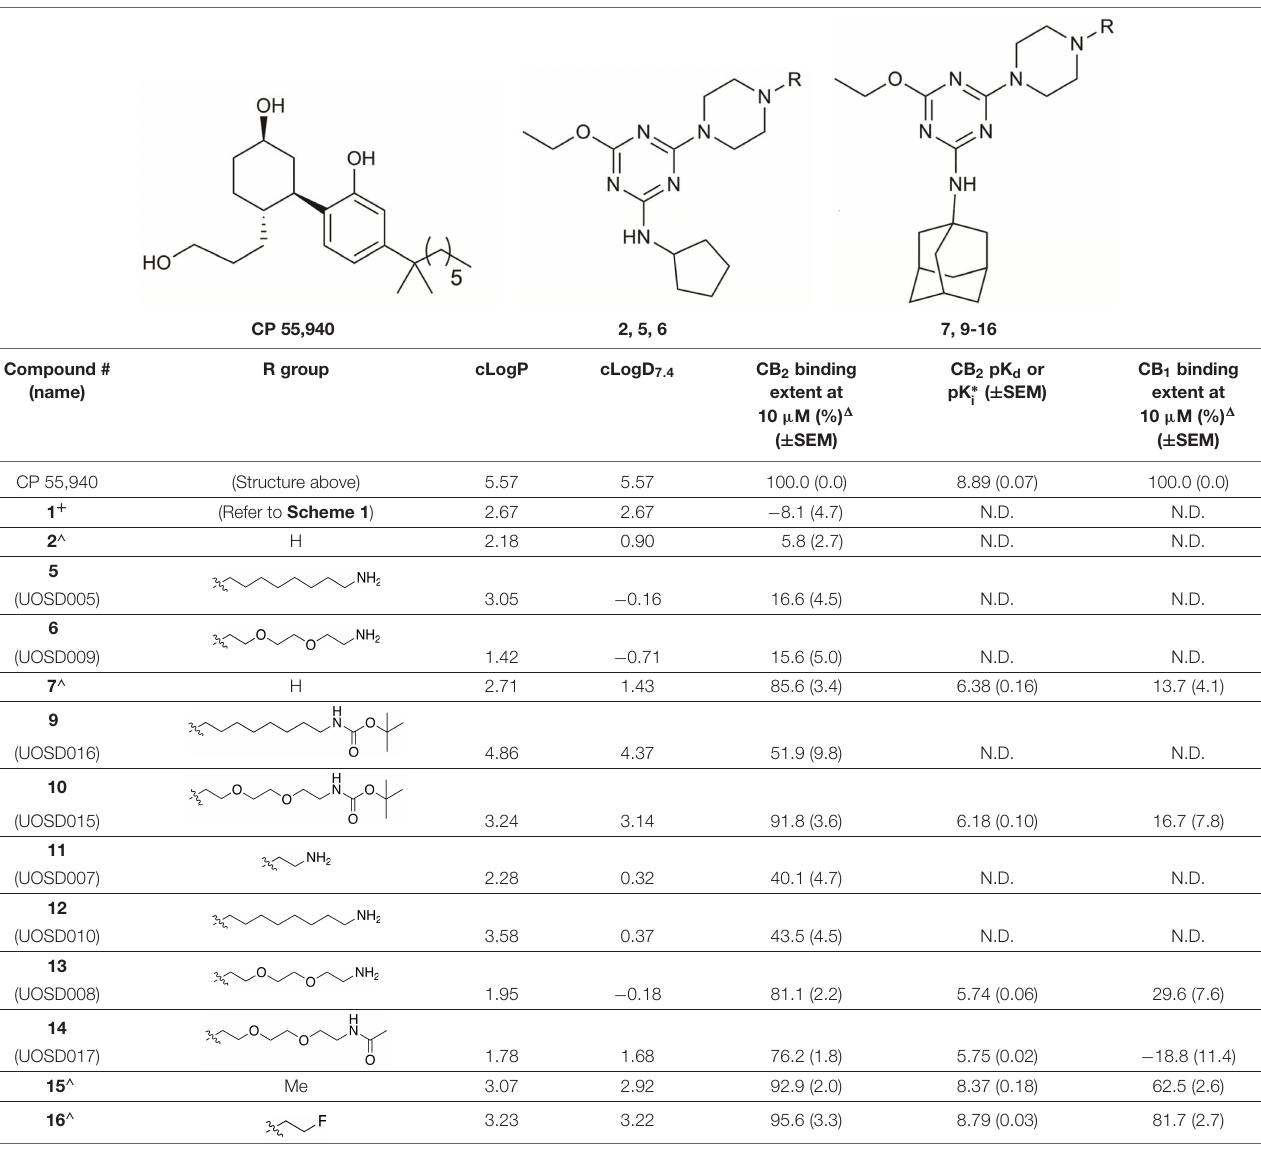
TABLE 1 | Structures and hCB 2 binding affinities for CP 55,940 and 2,4,6-trisubstituted 1,3,5-triazine